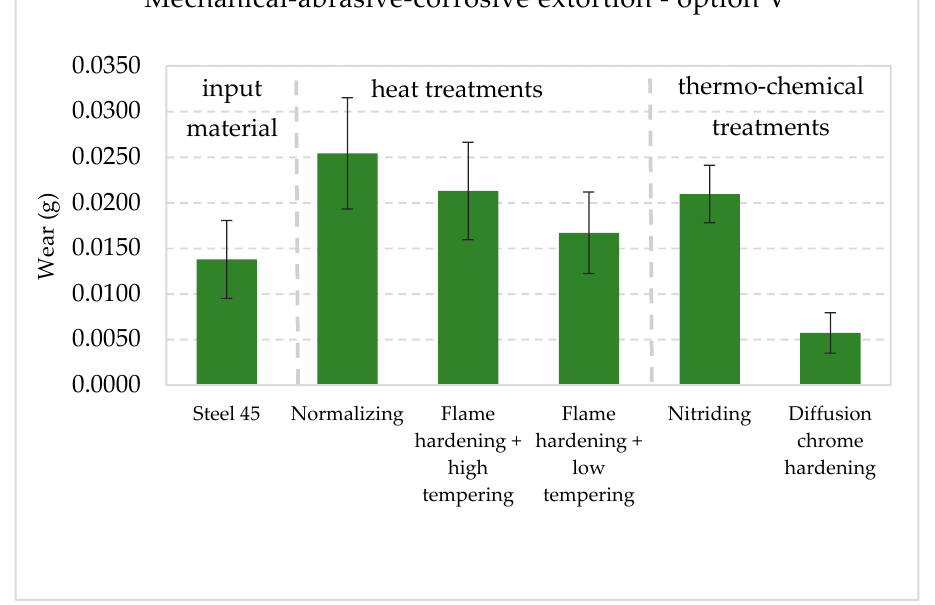
Figure 17. Wear I M + I C + I A in the conditions in mechanical, abrasive and corrosive conditions with 90% confidence semi-intervals [40].